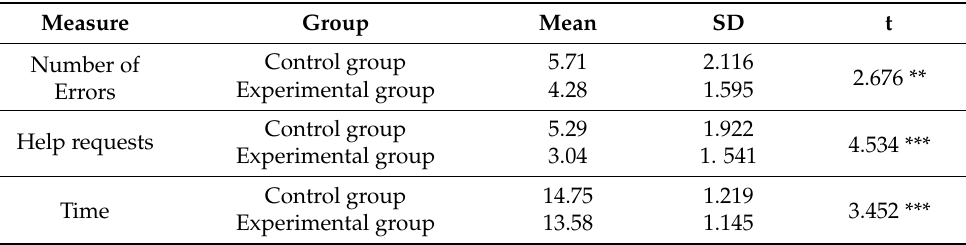
Table 3. The interaction between the two groups of students was tested using a t